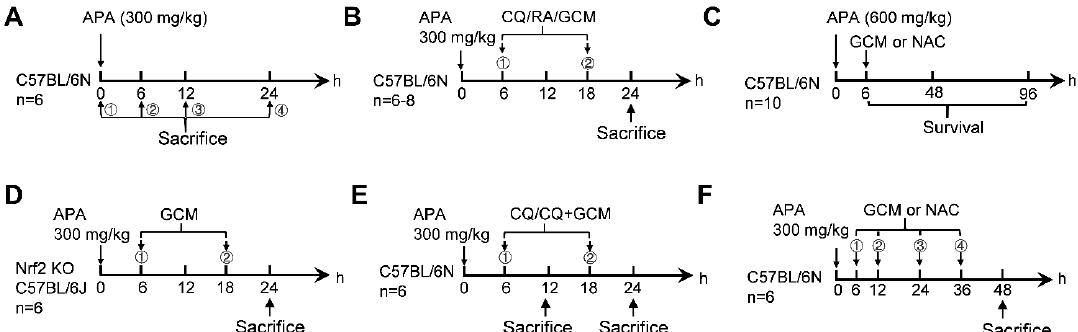
Figure 1. Experimental design. Mice were fasted overnight for 16 h before intraperitoneally (i.p.) injected with APA. Blood and liver tissues were collected at the time point of sacrifice. ( A ) The time–course experiment. ( B ) Autophagic flux confirmation experiment. ( C ) The survival experiment. ( D ) The experiment for the investigation of Nrf2. ( E ) The verification experiment. ( F ) The long-term treatment experiment. APA, acetaminophen; CQ, chloroquine diphosphate salt; RA, rapamycin; GCM, glycycoumarin; NAC, N -Acetyl- L -cysteine; KO,